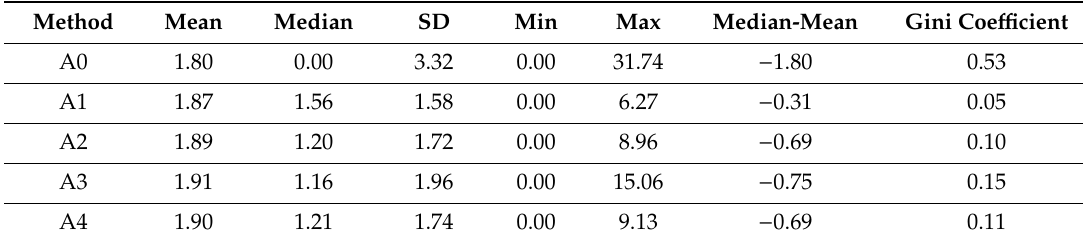
Table 4. Summary statistics of physical rehabilitation resources accessibility scores by methods